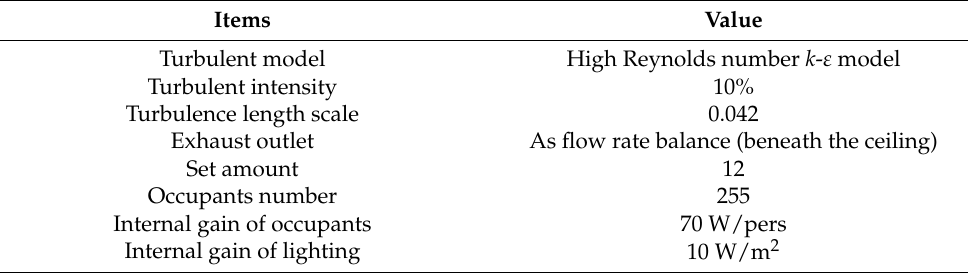
Table 5. The settings of outlet in each